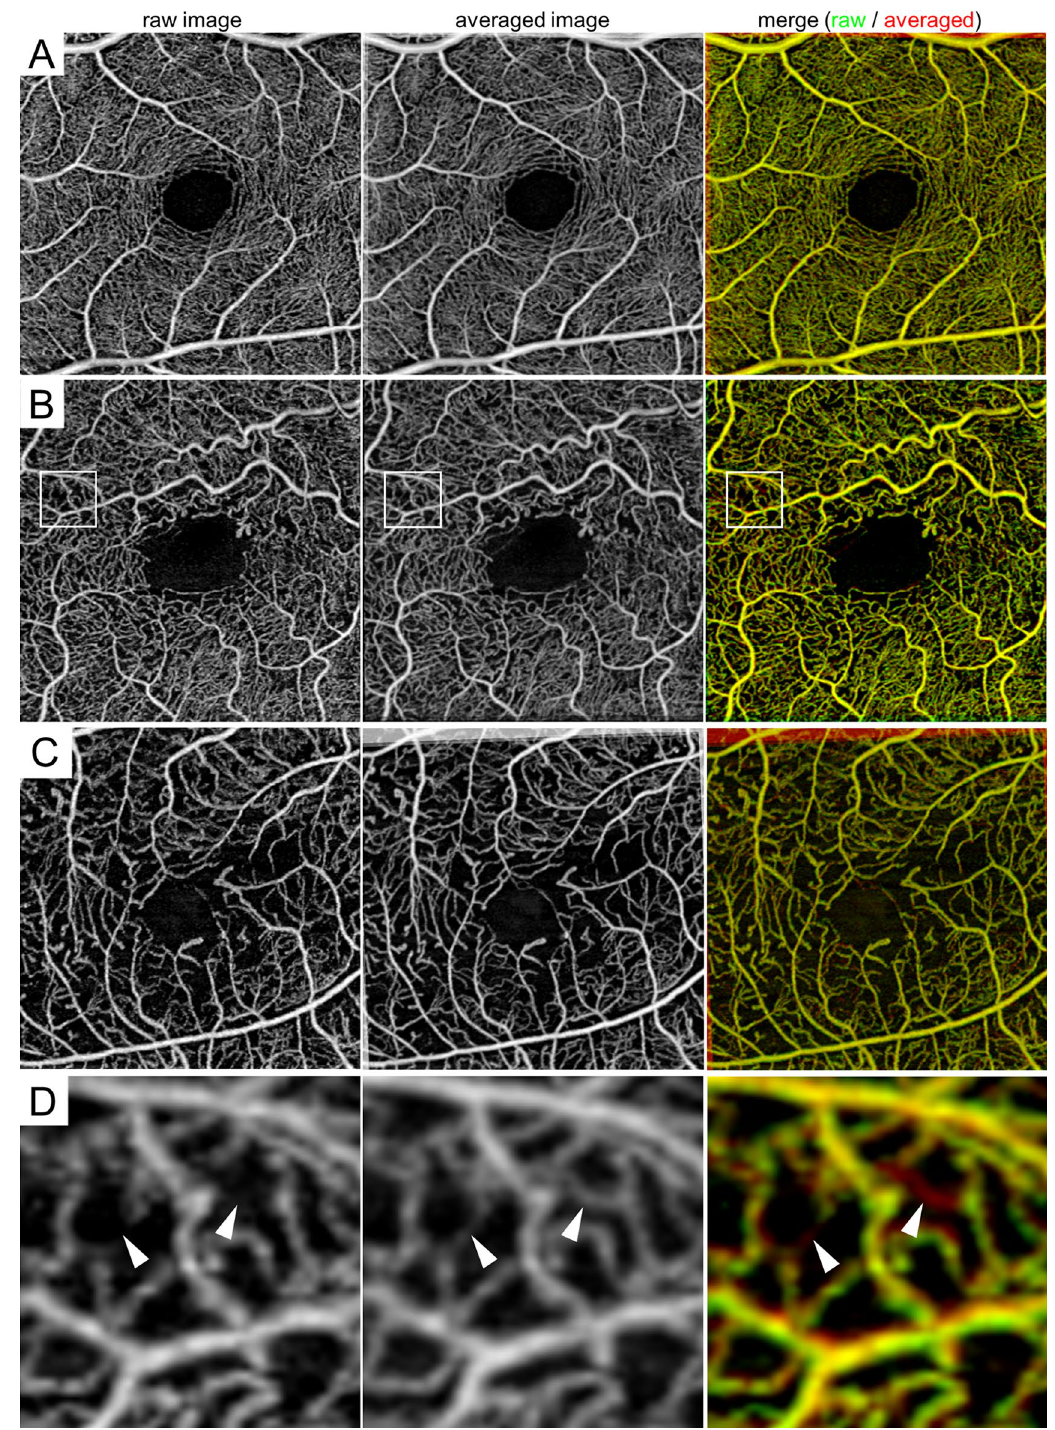
Figure 1. Segmental loss of flow signal and concomitant enlargement of intercapillary spaces on SS-OCTA images in diabetic retinas. ( A ) The flow signals in the raw and averaged images appeared to be similar to each other in the 3 × 3 mm en face image of the superficial layer in a representative nondiabetic subject. ( B ) In contrast, the flow signals are absent segmentally in a representative case of moderate NPDR, resulting in the enlargement of intercapillary spaces. ( C ) The shape of enlarged intercapillary spaces appears to be simple and smooth in a representative case of PDR ( C ). ( D ) Magnified image of the rectangle in panel B. The raw image shows transient loss of flow signals in some retinal capillaries (arrowheads), compared to the uninterrupted vessels in the averaged image. Left column = raw image; middle column = averaged image; right column = merged